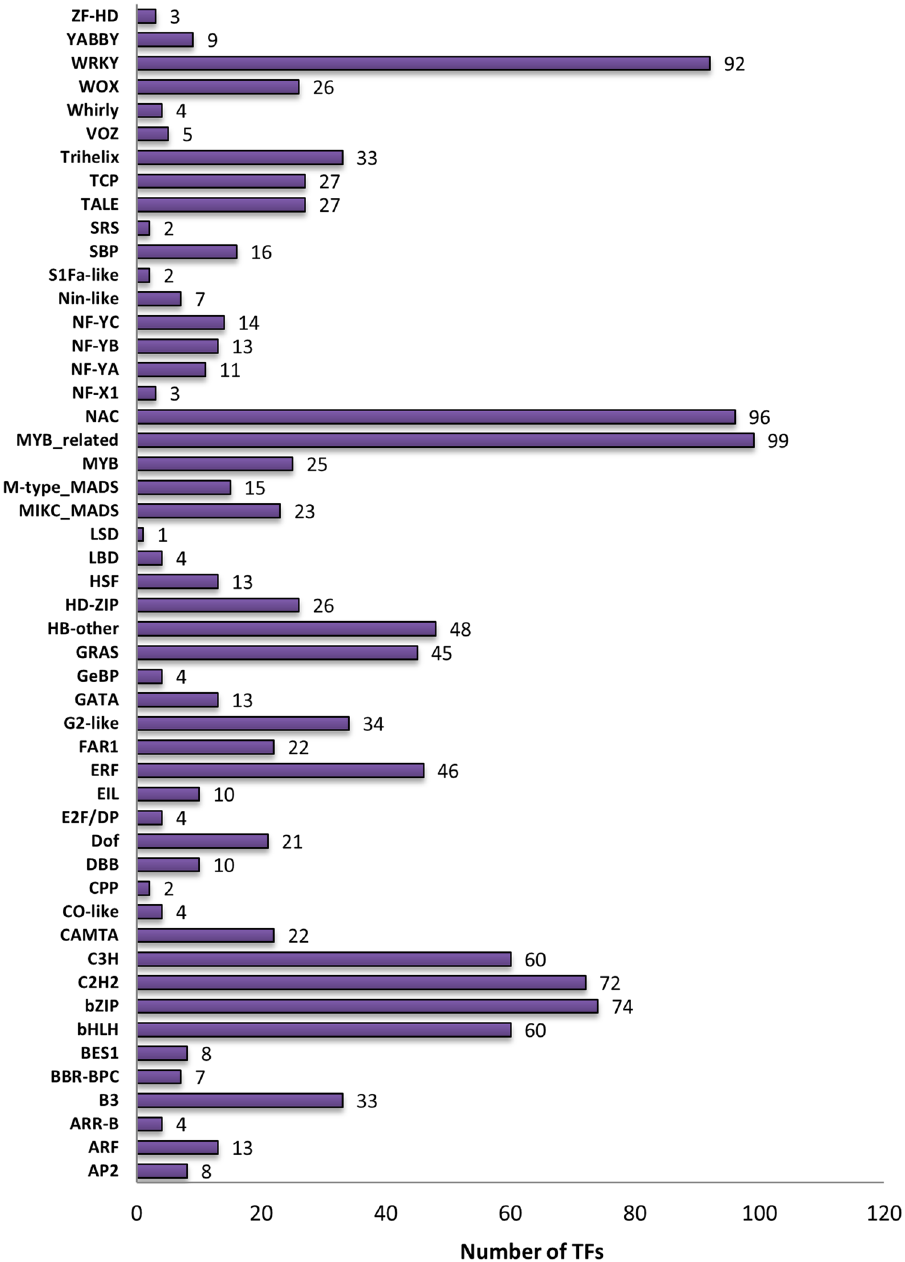
Figure 3. The families of transcription factors detected in the D. cymosum transcriptome. A total of 1220 transcription factors were assigned to 50 unique families using